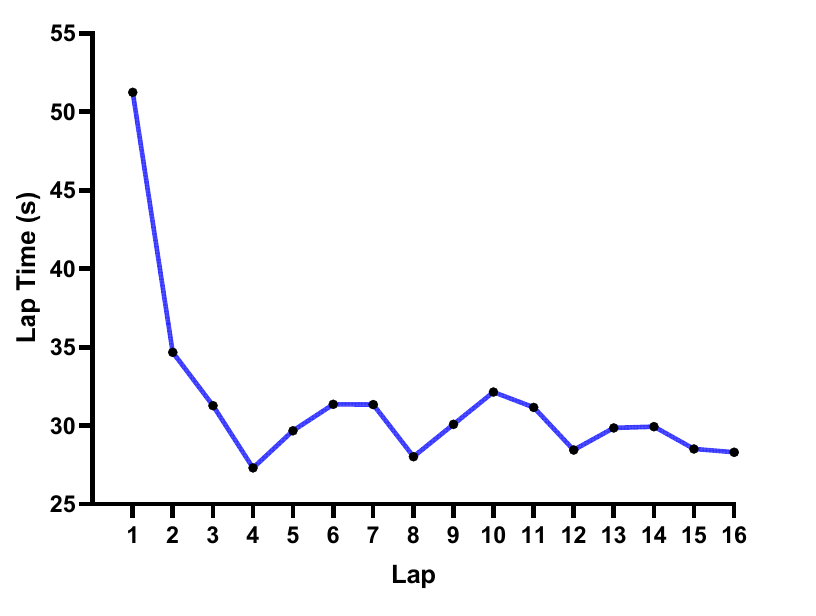
Figure 1. Lap time spent on each lap. Table 2. Three-ways ANOVA for each lap time and total time spent.